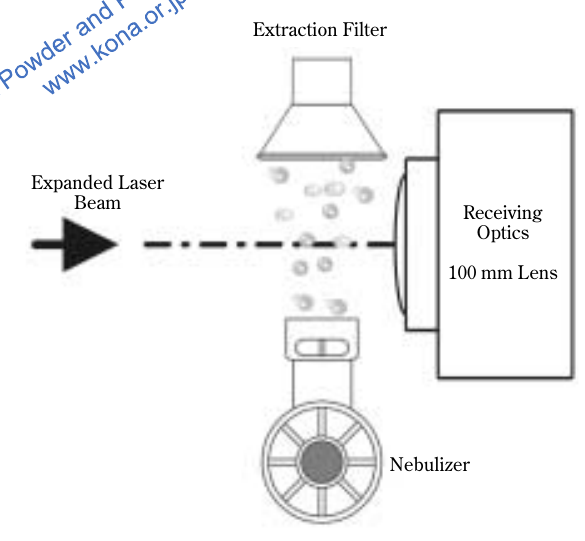
Fig. 14 Configuration for nebulizer droplet size analysis by laser diffractometer (from [141]: used by permission,